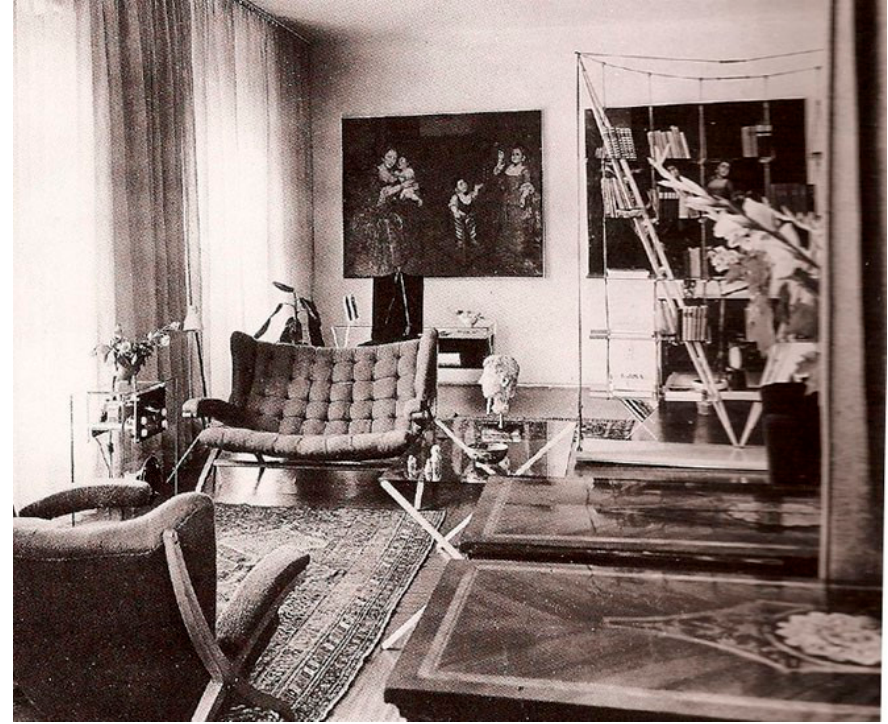
Figure 8. The bookcase “Veliero” in the living room of Albini’s flat (1938). Photo from (Romano 1941).